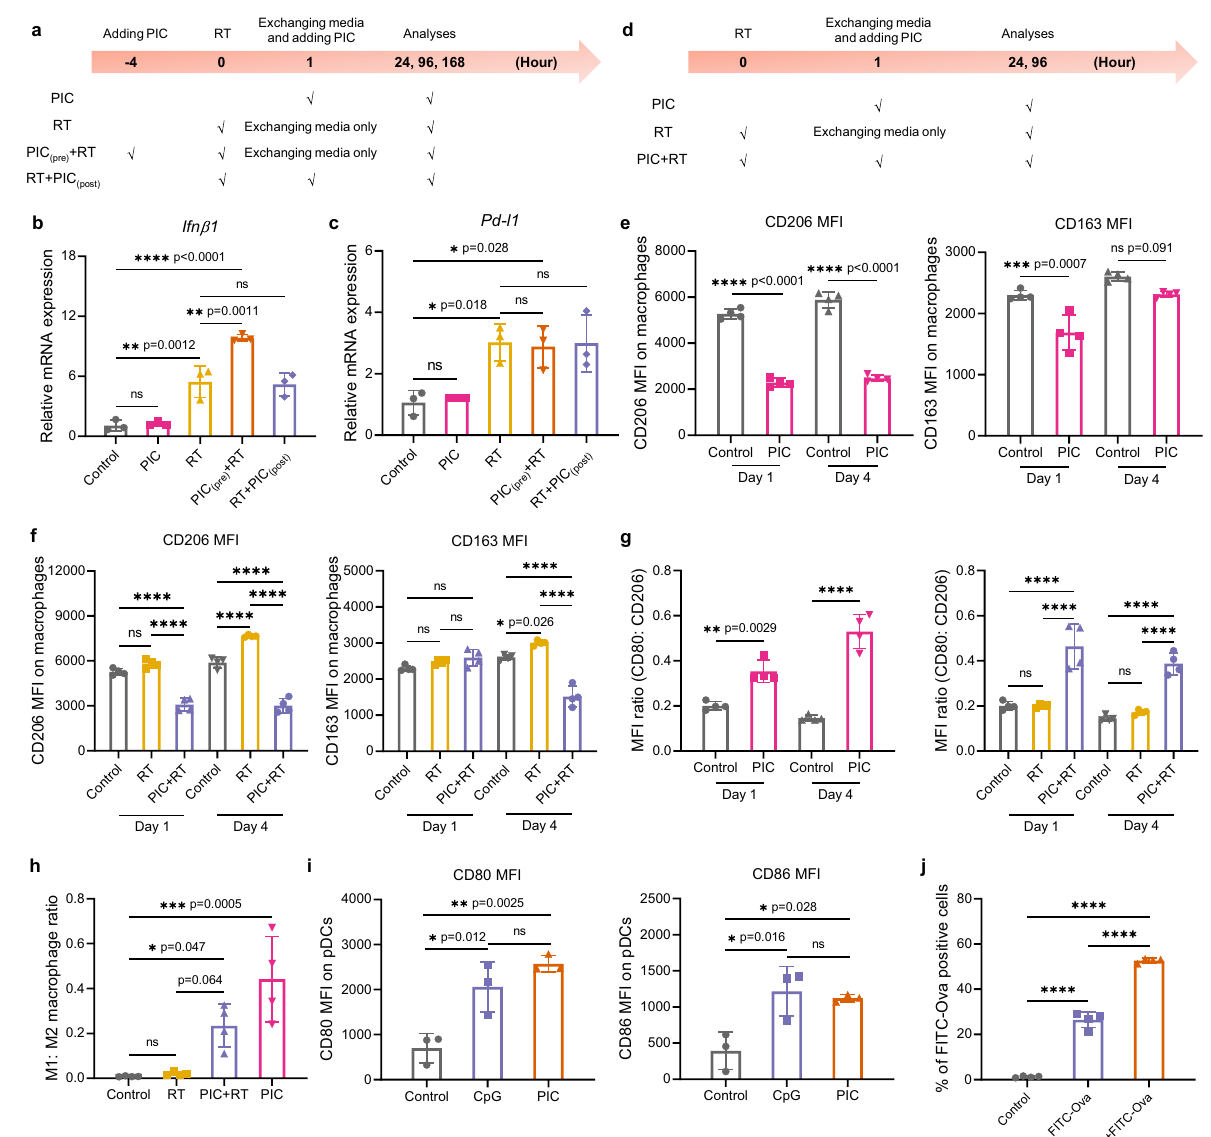
Fig. 2|Theimmunomodulatoryeffect ofPICinvitro.a Schemeforthe RT-qPCR studiesofB78cells.TherelativemRNAexpressionof b Ifn β 1 and c Pd-l1 inB78cells at day 7 after initiation of indicated treatments. PIC: 4.67 μ g/mL; RT: 12Gy. ( n =3 biologically independent samples). d Scheme for the study of the macrophage polarization effect of PIC on BMDMs. The MFI of CD206 and CD163 on CD11b +